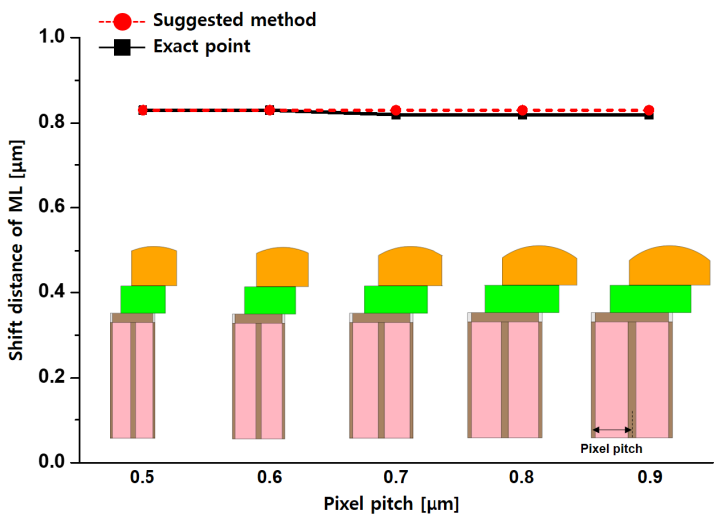
Figure 4. Comparison of simulation and calculation results with the varied pixel pitch from 0.9 μ m to 0.5 μ m on the same conditions of microlens (ML) height and ROC at CRA 35°. The ROC of a microlens directly affects its focal point and focal length. Optimized microlens height and ROC are essential to improving pixel performance. On the other hand, the microlens ROC is excluded from Equation (1) in this paper. Therefore, the relationship between the ROC and the optical stack’s alignment is required in order to confirm the proposed method’s effectiveness. Figure 5 shows simulated pixel structures by changing only the ROC of the microlens. The simulated pixels have the same pixel pitch and microlens height as 1.0 and 1.4 µ m, respectively. Compared to the exact point from the simulation, the maximum shift distance difference was 0.02 µ m at the pixel having 2.0 µ m of microlens ROC and the maximum relative error rate was insignificantly shown as 2.22%.